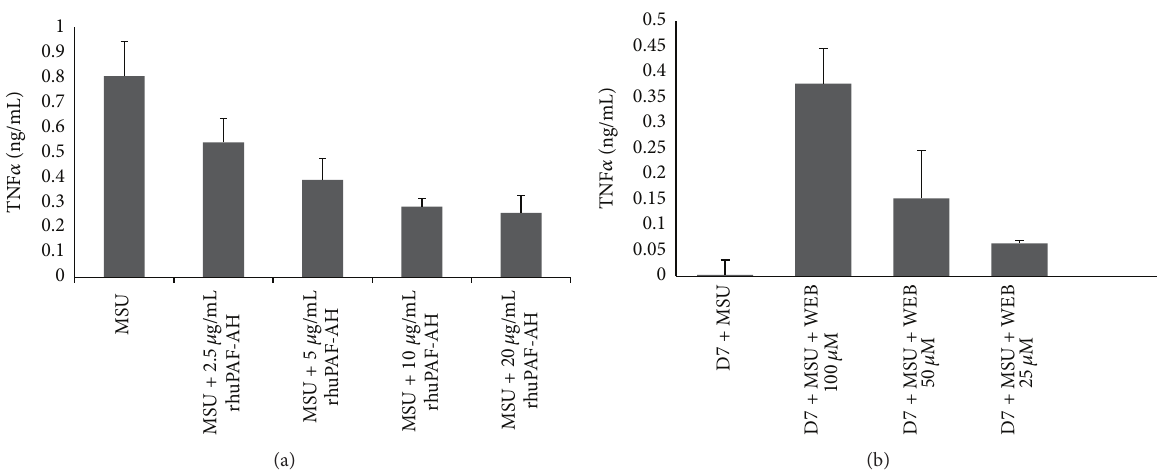
Figure 3: (a) Effect of recombinant human platelet activating factor acetylhydrolase (rhuPAF-AH) on TNF 𝛼 release from monocytes. Freshly isolated monocytes were cultured overnight and treated with rhuPAF-AH at concentrations of 2.5, 5, 10, and 20 𝜇 g/mL, respectively, for 45 minutes prior to addition of MSU crystals for 24 hours. Afterwards, collected supernatants were analysed for TNF 𝛼 by ELISA. Results are mean and SEM of 3 experiments. (b). TNF 𝛼 production unmasked by costimulation of in vitro differentiated macrophages with MSU crystals and WEB2086. Monocytes were cultured in vitro for 7 days and stimulated with MSU crystals for 24 hours with or without the PAF antagonist (WEB2086). At 100 𝜇 M, coincubation with WEB2086 and urate crystals caused the release of TNF 𝛼 with 𝑃 = 0.002 (Student’s paired 𝑡 -test). Conditioned supernatants were analysed for TNF 𝛼 production by ELISA. Differentiated macrophages were also coincubated with WEB2086 at 100 𝜇 M which reduced the amount of TNF 𝛼 unmasked. Values are mean and SEM of 4 experiments. D7 = supernatants from day 7 macrophages, D1 = supernatants from day 1 monocytes, and WEB = WEB2086 (PAF antagonist).